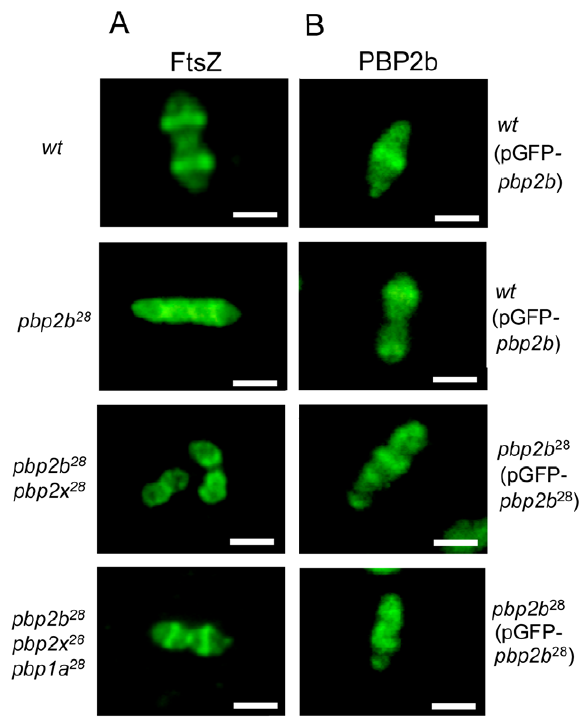
Figure 6. Protein localization in wild-type and pbp mutants by fluorescence microscopy. A) Localization of FtsZ. Microphotographs indicate the most common patterns of FtsZ localization through the cell cycle for wt and pbp mutants. Polyclonal antibody against FtsZ was used for its detection by immunofluorescence microscopy. In the Cp1015 ( wt ) strain, FtsZ is localized at the equatorial ring and septum, In Cp 1015 pbp2b 28 , the patterns suggest FtsZ delocalization and cell cycle disruption. The triple pbp mutant showed a wild-type FtsZ placement. B) Localization of PBP2b 28 -GFP. Microphotographs indicate the most common patterns found for PBP2b localization through the cell cycle in the wt and pbp2b 28 mutant. Representative images are shown from experiments that were repeated independently three times (bar scale, 1 m m).